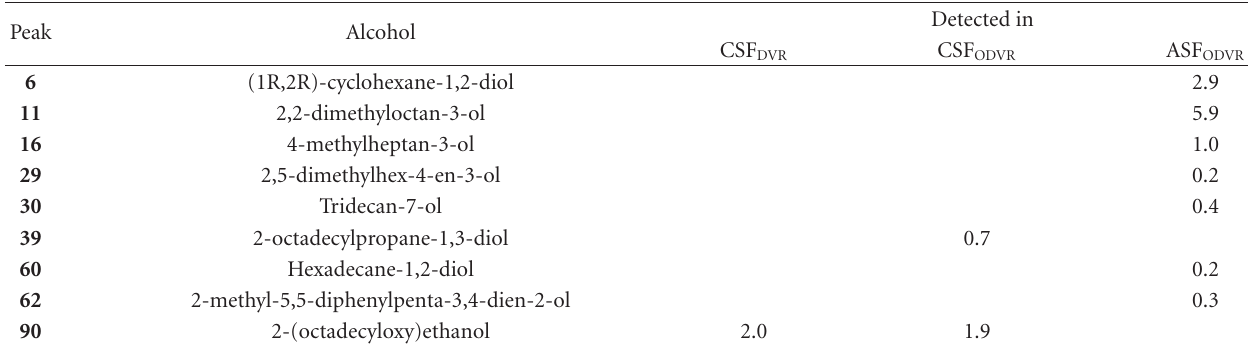
Table 7: Alcohols detected in the products from CSF DVR , CSF ODVR and ASF ODVR .